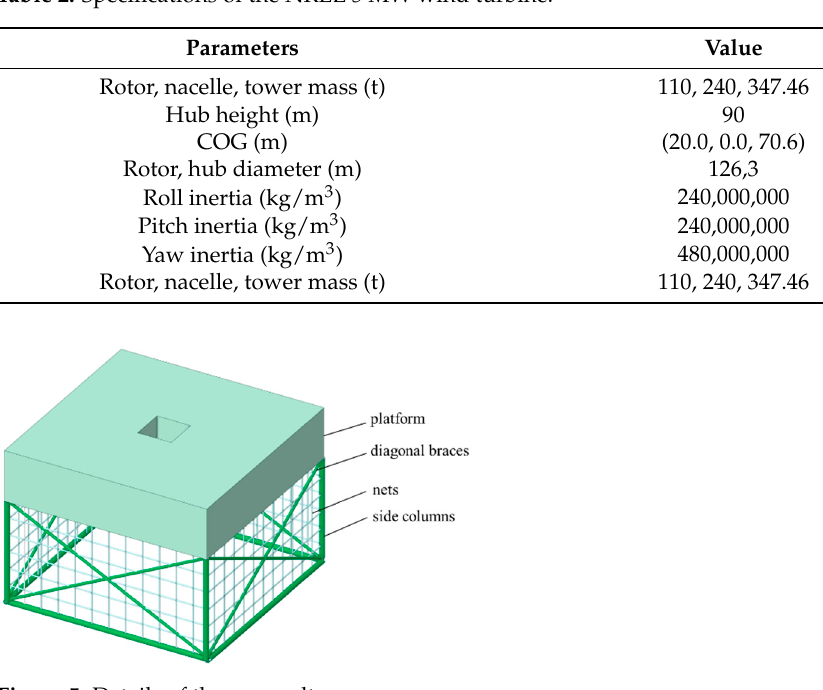
Figure 5. Details of the aquaculture cage. Table 1. Main parameters of the barge-type platform.